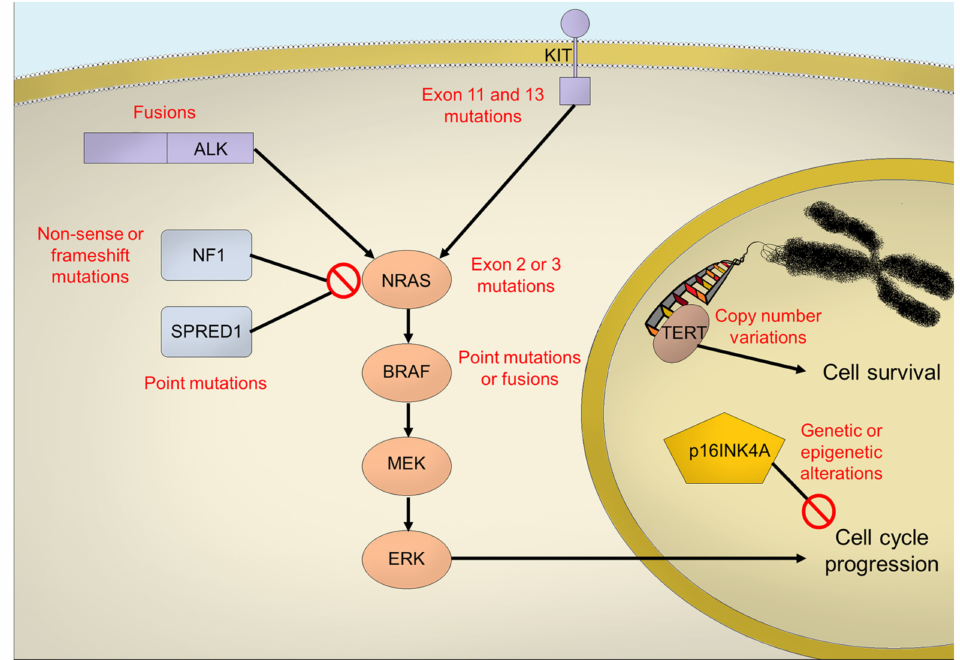
Figure 1. Representation of the most frequent genetic alterations in a mucosal melanoma cell and the principal molecular pathways